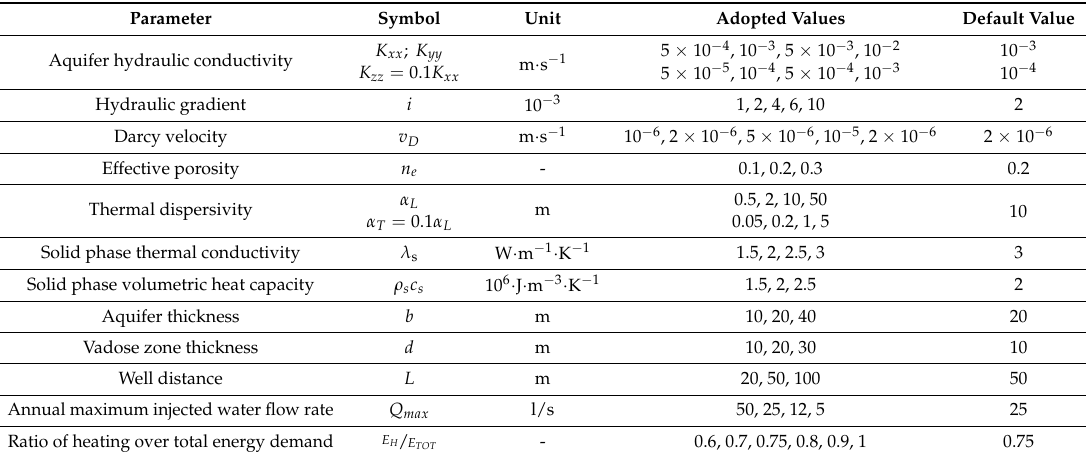
Table 1. Parameter values assigned in the